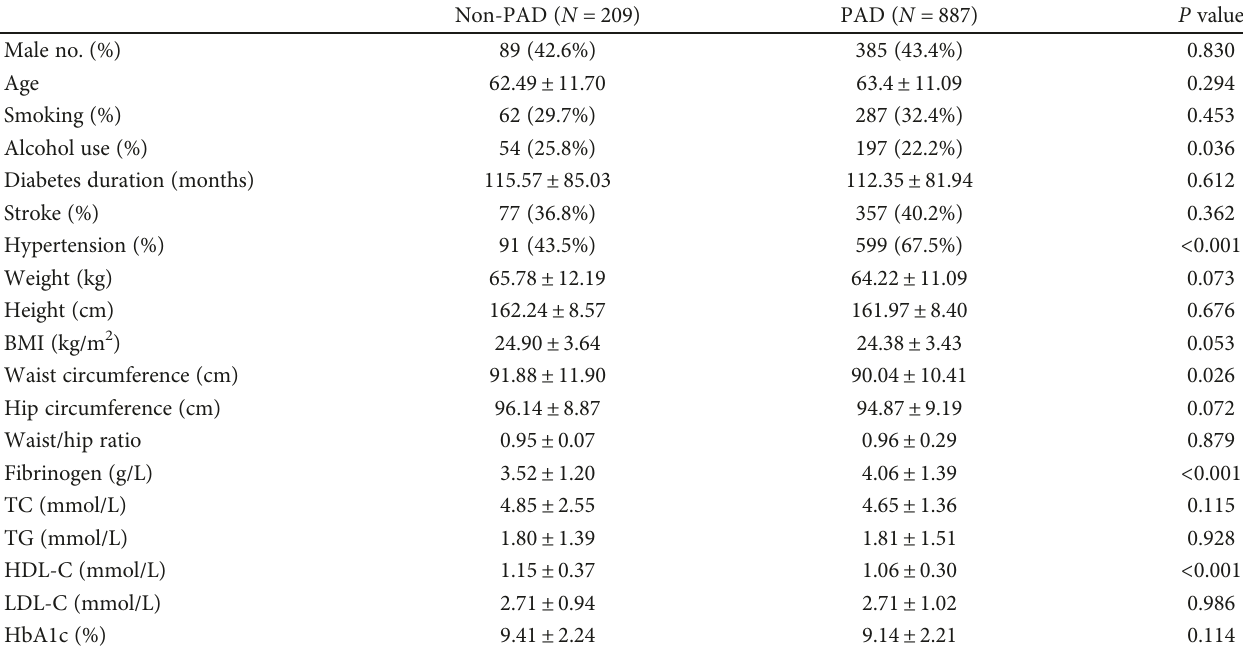
Table 1: Baseline characteristics between subjects with and without